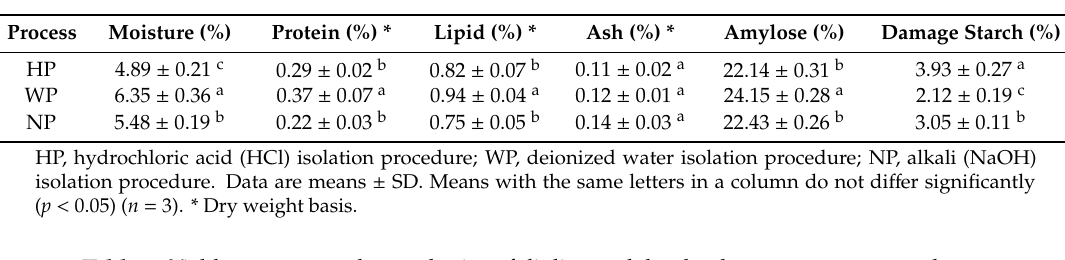
Table 2. Yield, recovery, and granule size of djulis starch by the three treatment